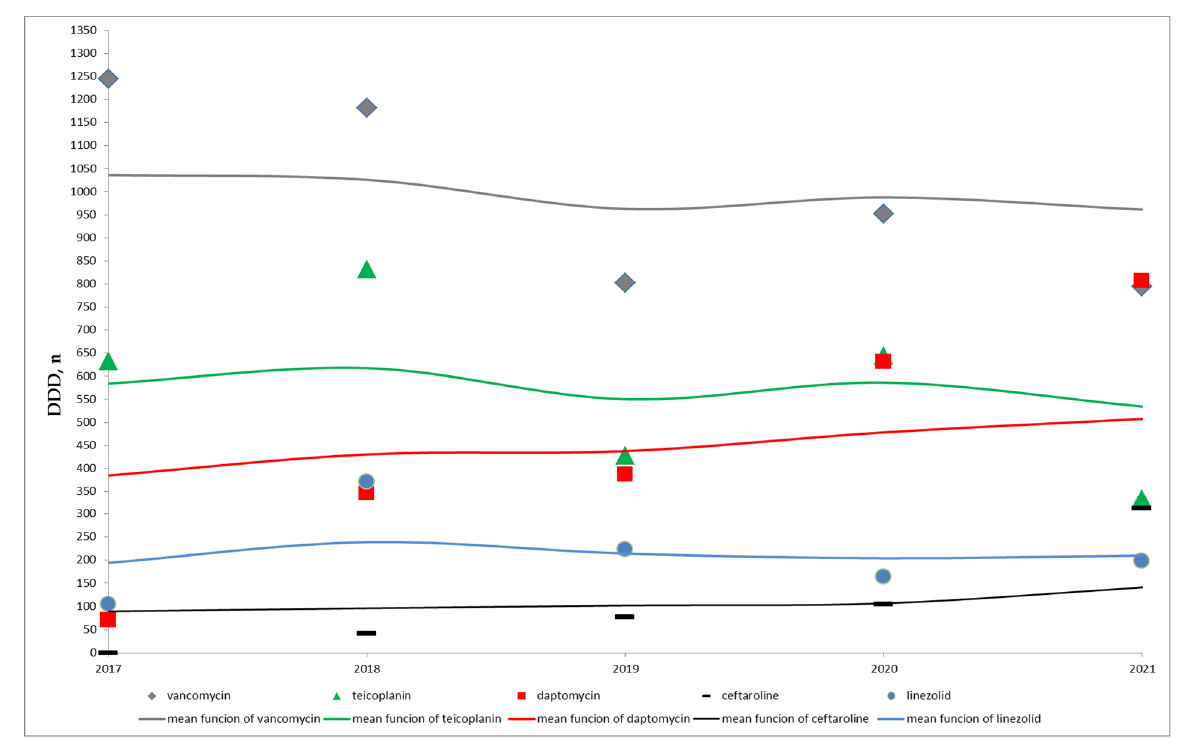
Figure 1. Time distribution of the number of antibiotic DDDs and of the respective mean functions- non parametric local-constant kernel regressions.